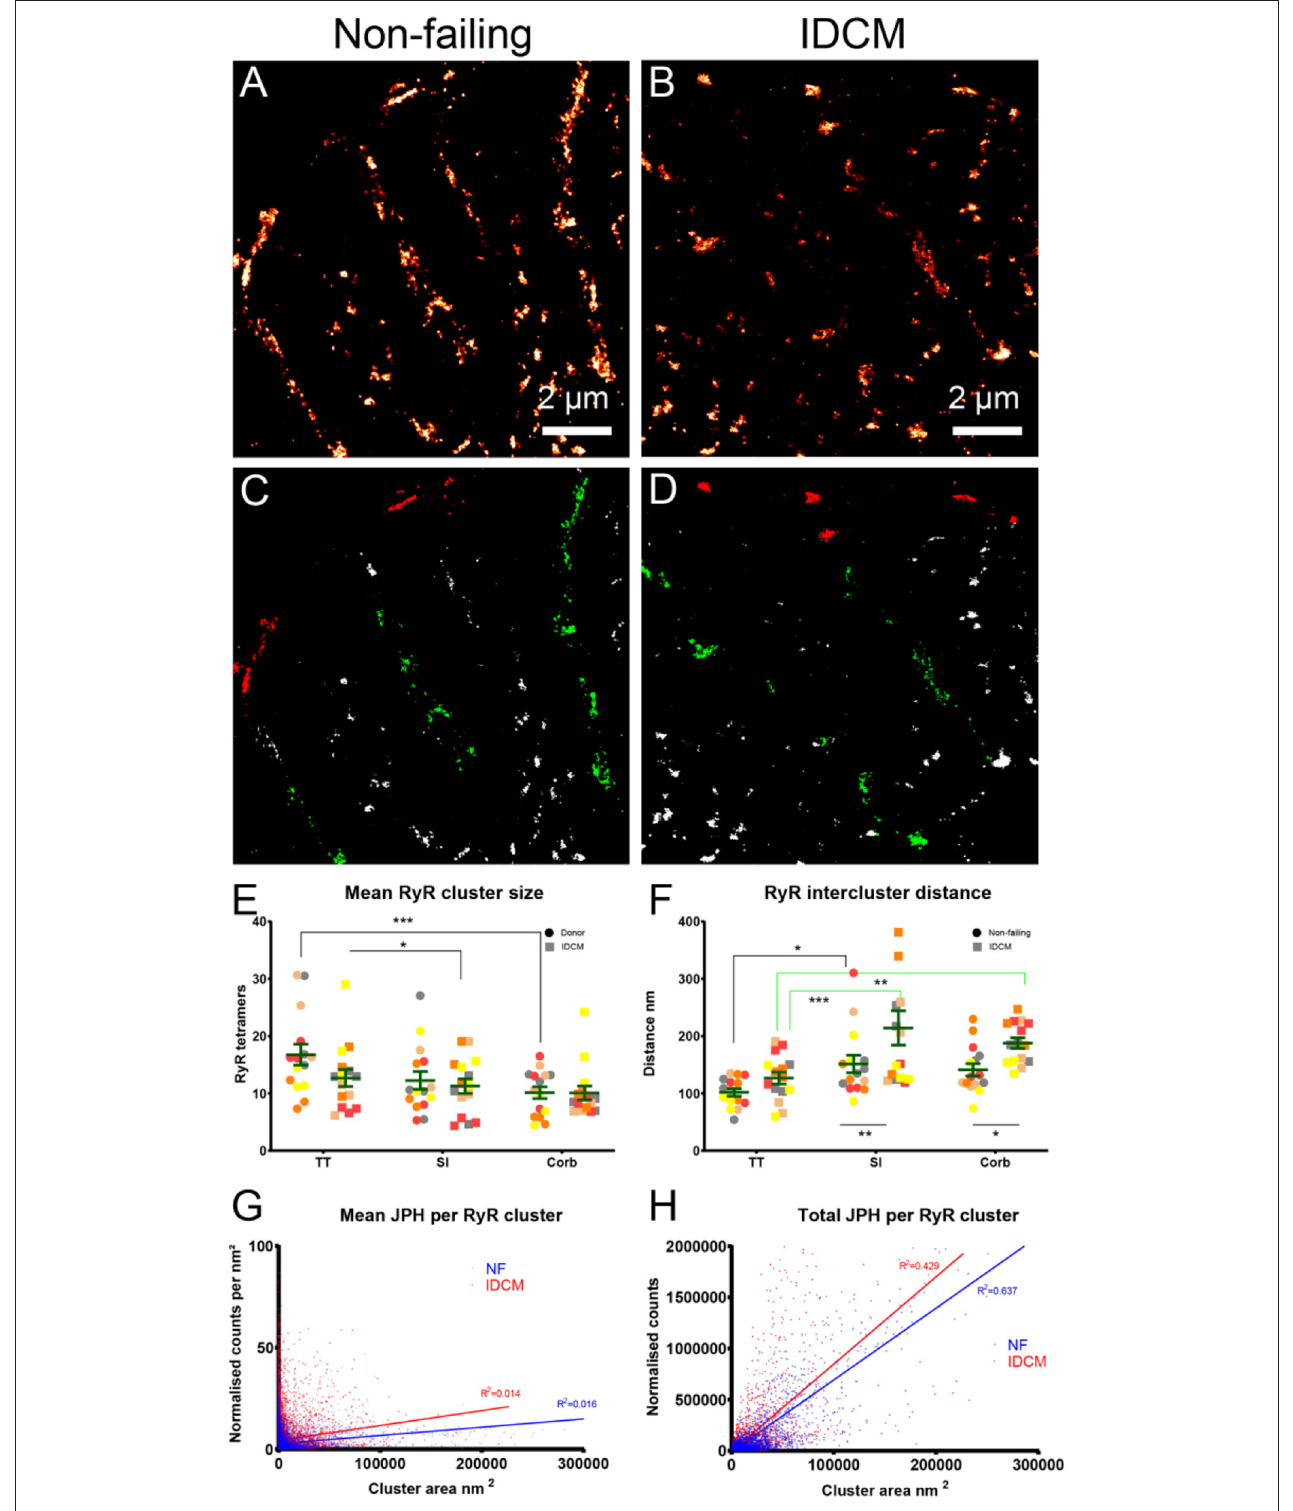
FIGURE 3 | Super-resolution imaging of RyR clusters in donor and IDCM human hearts. (A) RyR clusters in Donor myocyte. (B) RyR clusters in IDCM myocyte. (C) Binary mask of “ (A) ” segmented into TT (green), Sl (red), and Corb regions (white). (B) RyR clusters in IDCM myocyte. (D) Binary mask of “ (B) ” segmented into TT, Sl, and Corb regions. (E) Mean RyR clusters size in NF and IDCM hearts. (F) Mean RyR intercluster distance in NF and IDCM hearts. Symbols of the same colour in